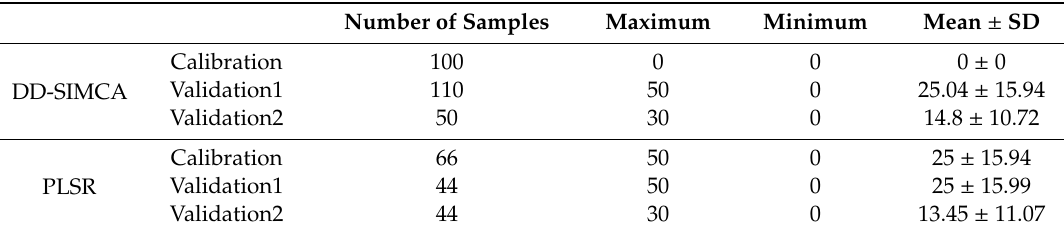
Table 1. Summary of the descriptive statistics for the calibration and validation datasets used in the data-driven soft independent modeling of class analogy (DD-SIMCA) and partial least square regression (PLSR) analyses (excluding the number of samples, all units are in %). Number of